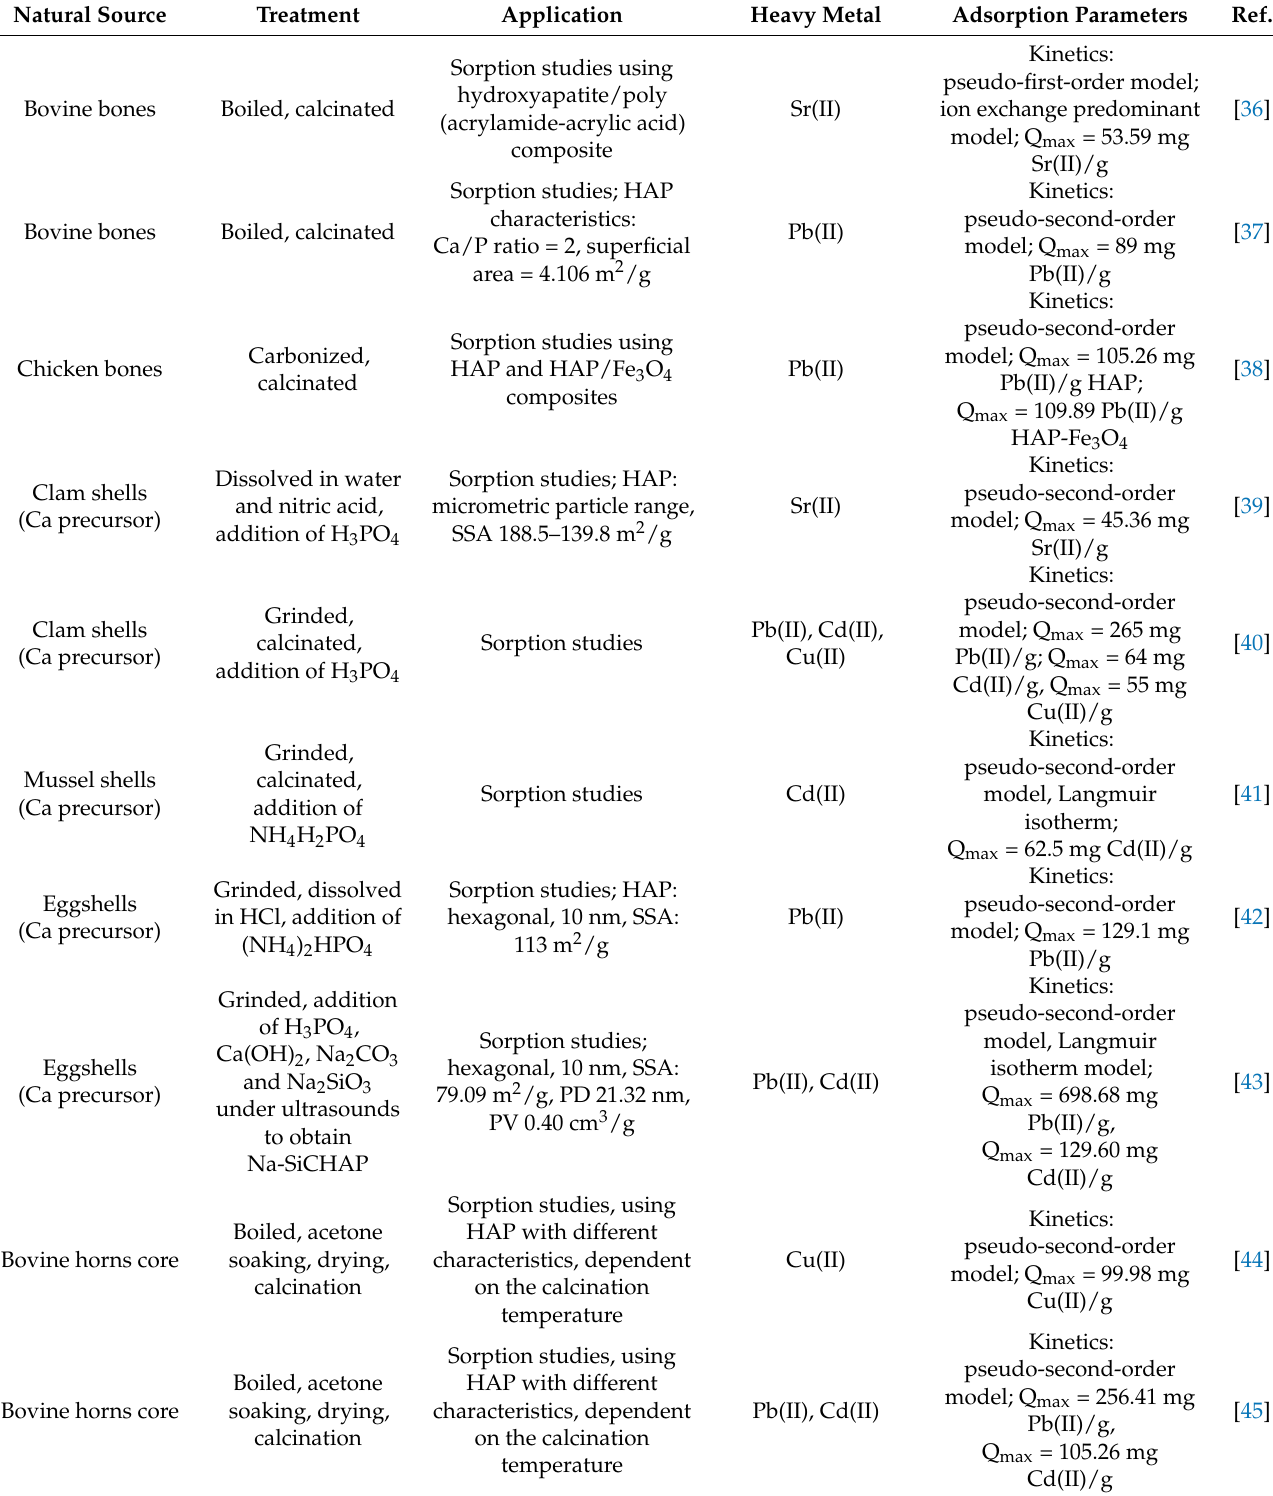
Table 3. Application of natural-derived hydroxyapatite for the removal of heavy elements (references presented in chronological order) 1